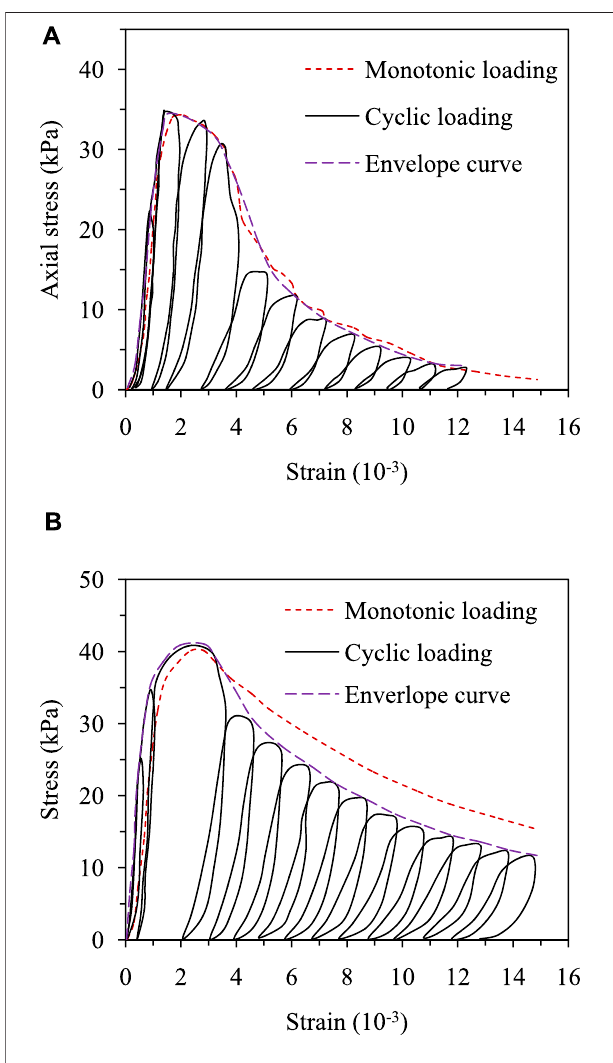
FIGURE 8 | Typical stress-strain curves of cementitious material under cyclic compressive loading: (A) without fi ber reinforcement, (B) with fi ber reinforcement (Li et al.,